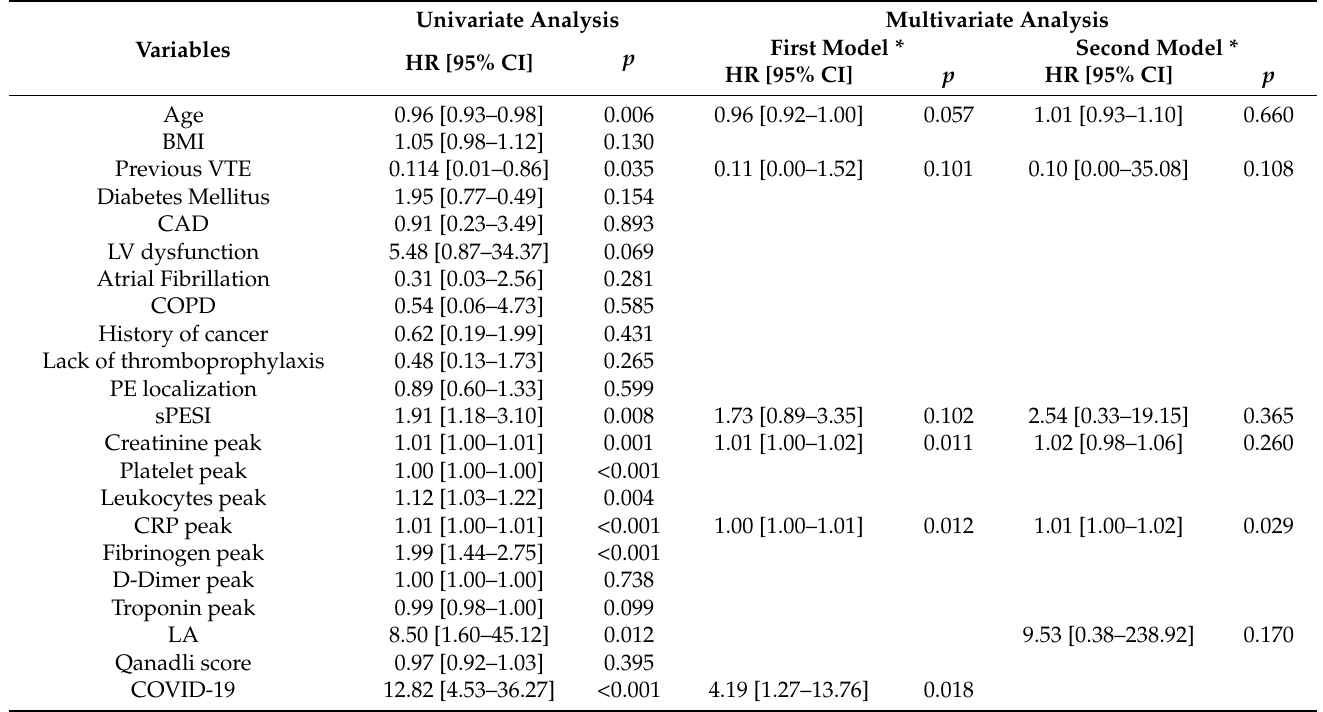
(Table 4). Given the collinearity of LA and COVID-19, we built two models for multivariate analysis. In the first model, including all candidates’ predictors, except LA, creatinine at peak (hazard ratio (HR) 1.01, confidence interval (CI) 95% [1.00–1.02], p = 0.011), CRP at peak (HR 1.00, CI95% [1.00–1.01], p = 0.012) and COVID-19 (HR 4.19, CI95% [1.27–13.76], p = 0.018) were independent predictors of transfer to the ICU in patients with APE. In the second model, including all candidates’ predictors, except COVID-19, only CRP at peak (HR 1.01, CI95% [1.00–1.02], p = 0.029) was independently associated with transfer to the ICU. Table 4. Univariate and multivariate analyses for occurrence of transfer to the intensive care unit in the study population.